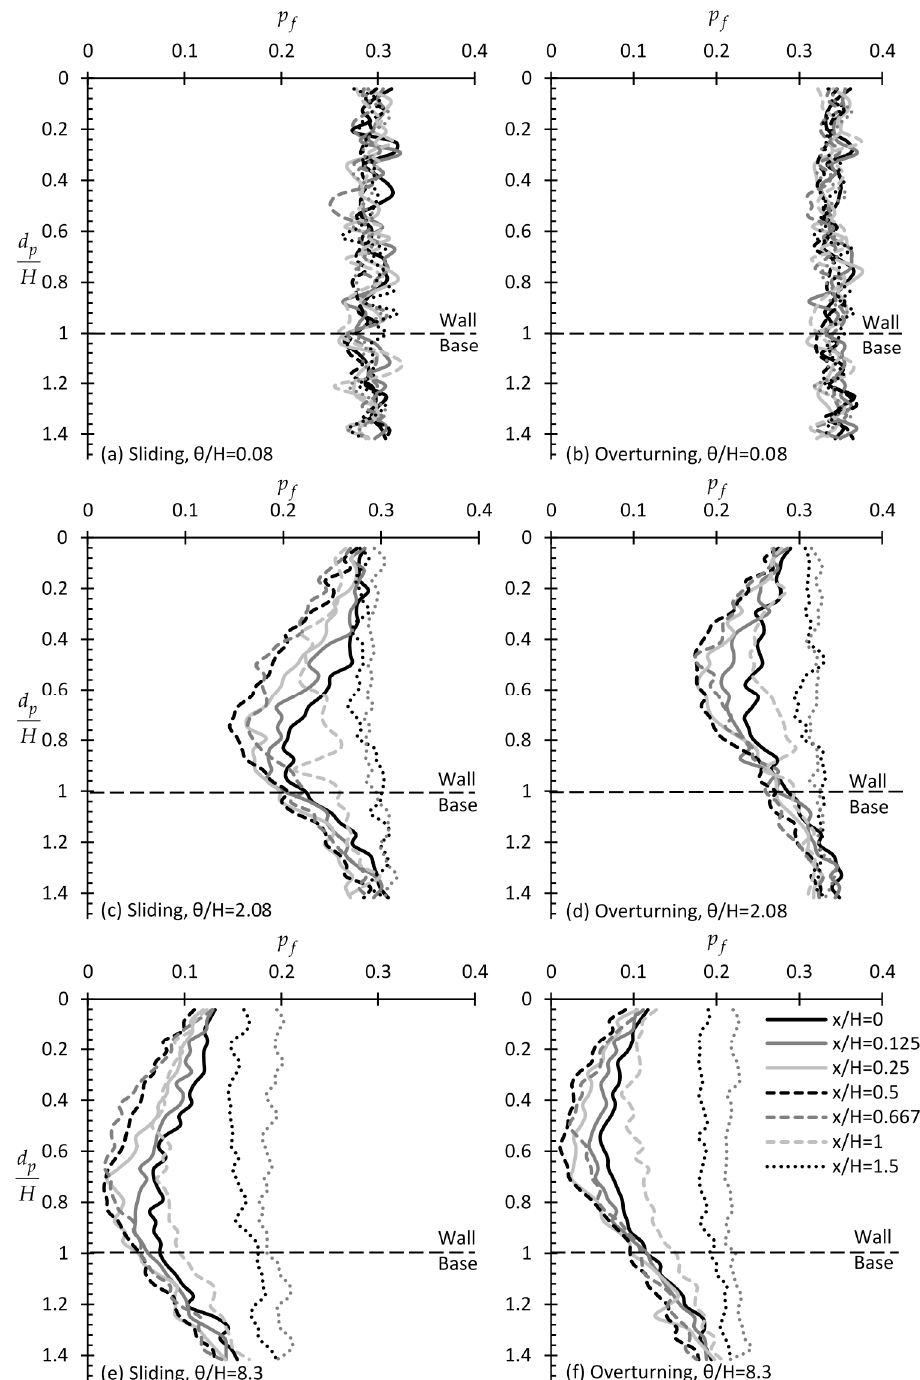
Figure 3. f p - p d H curves for various x H and H θ values for both the sliding ( a , c, e ) and Figure 3. p f − d p / H curves for various x / H and θ / H values for both the sliding ( a , c , e ) and overturning modes of failure ( b , d , f overturning modes of failure ( b , d , f ).